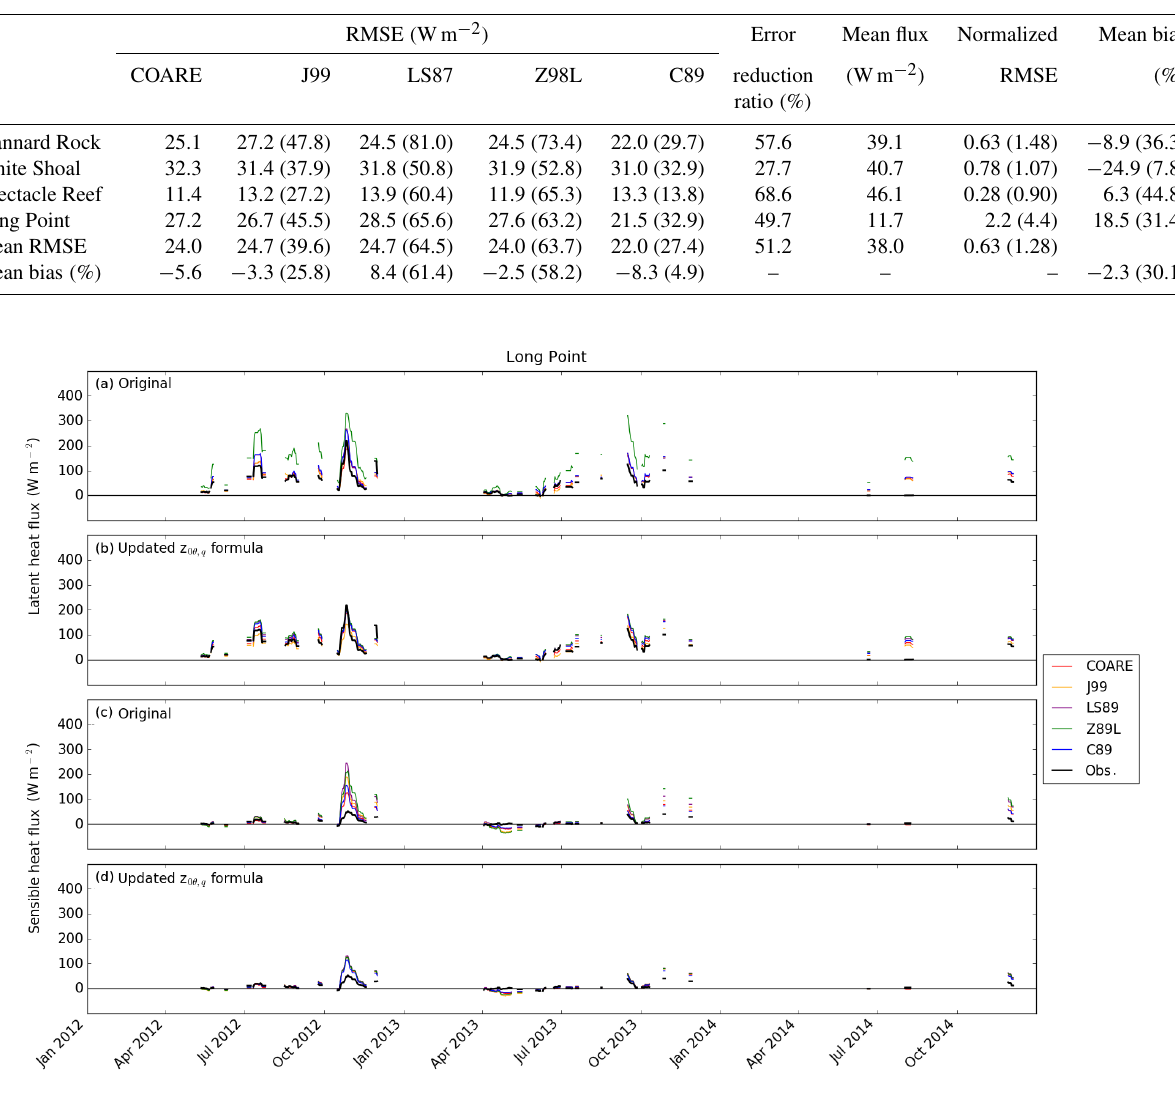
Figure 7. The same as Fig. 4, but at Long